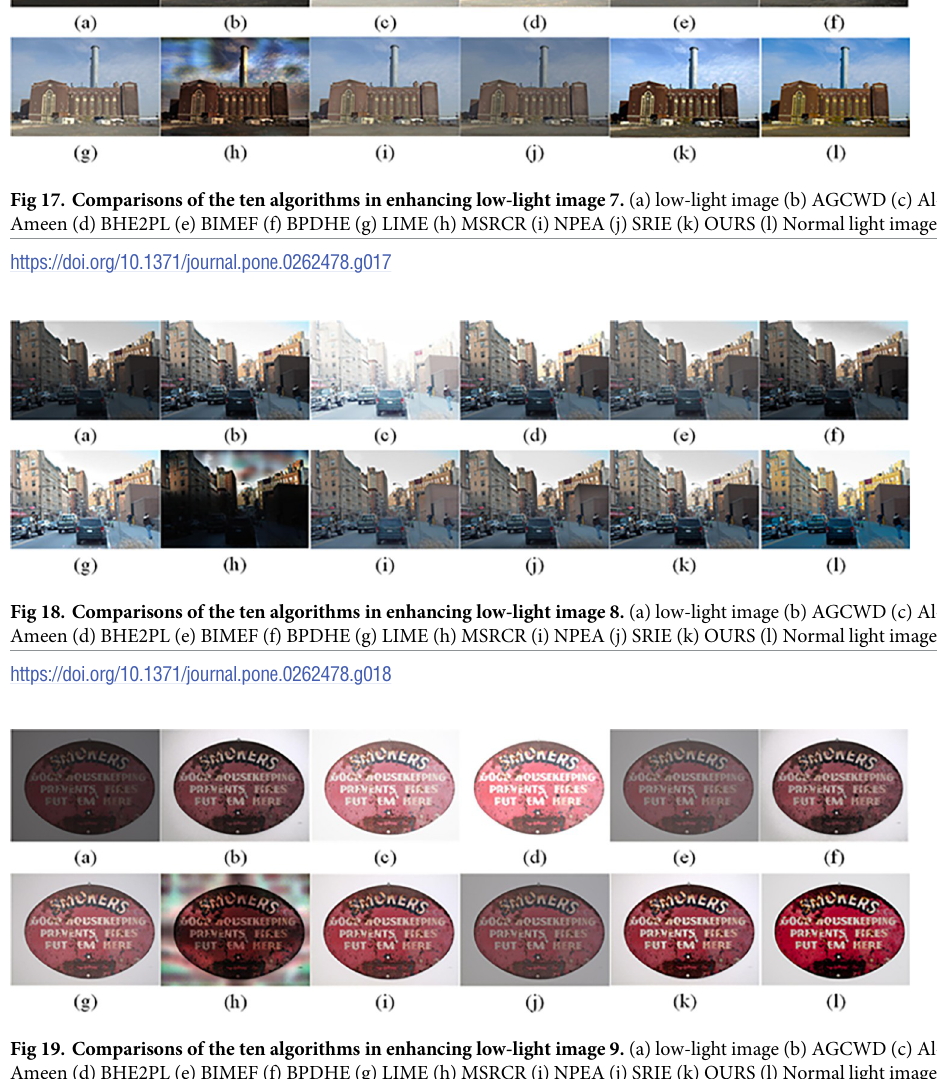
PLOS ONE | https://doi.org/10.1371/journal.pone.0262478 May 31,